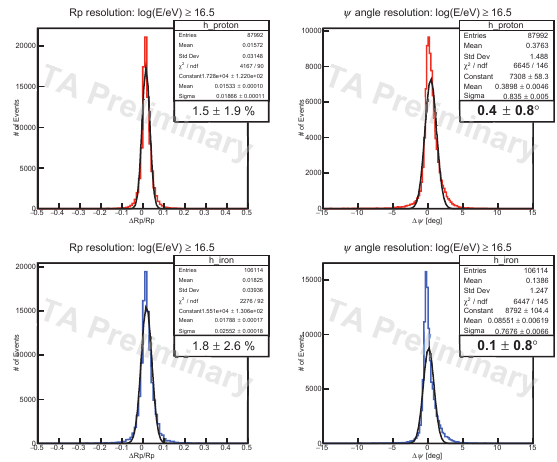
Figure 2: Reconstruction resolutions of the impact param- eter R p , the shower inclination angle in the SDP ψ , respec- tively. Top panels are shown for proton MC case and bot- tom panels are shown for iron MC case. The black curve is a Gaussian fit to the distribution of the uncertainty.